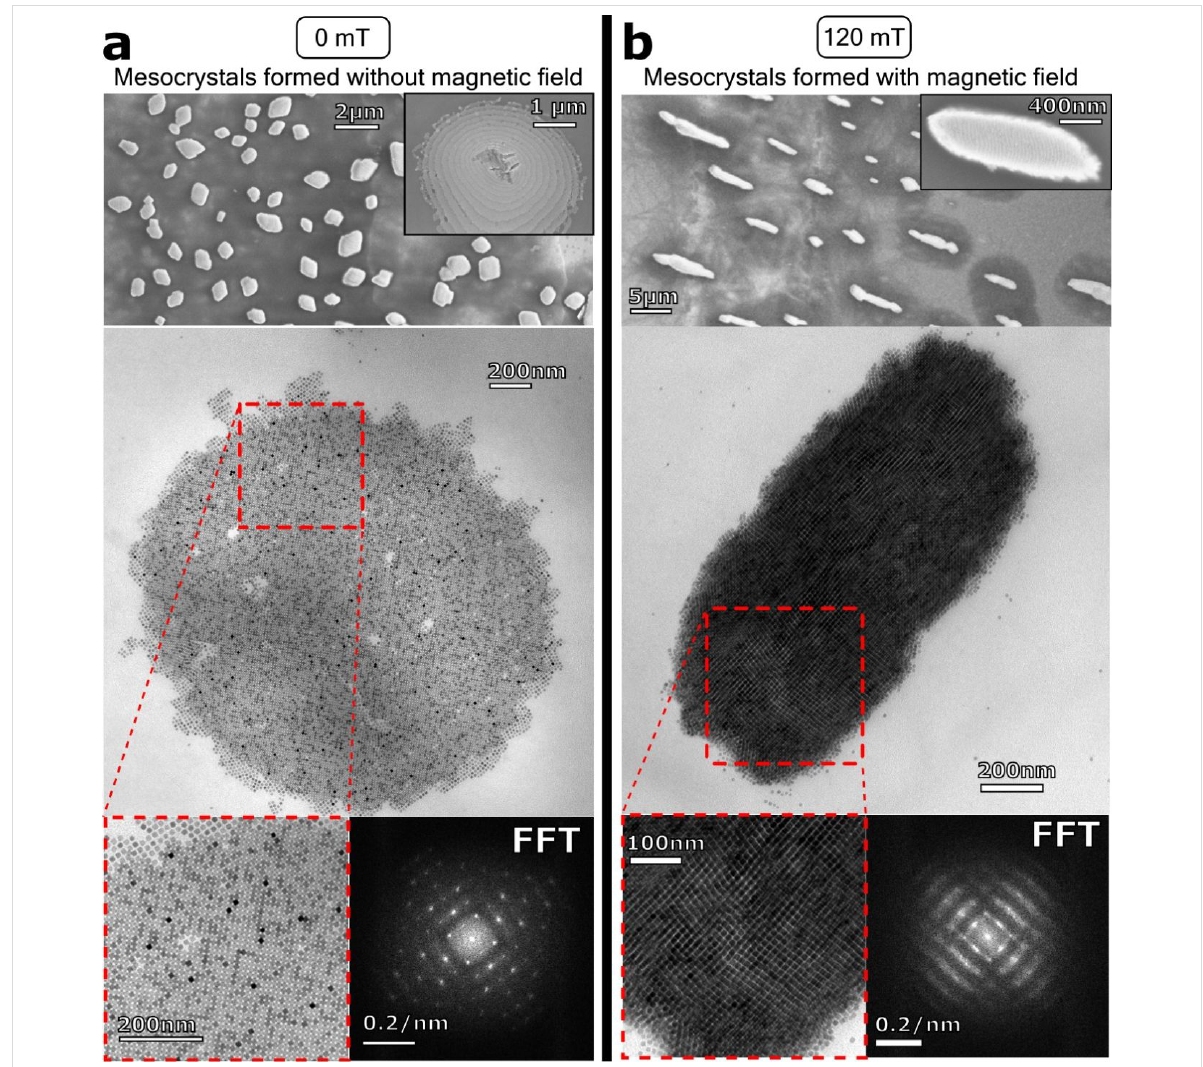
Figure 2: SEM and TEM images of mesocrystals produced without (a) and with (b) external magnetic field. The morphology of the mesocrystals changes using an applied external magnetic field (120 mT). The mesocrystals were elongated in the same direction and aligned along the direction of the used magnetic